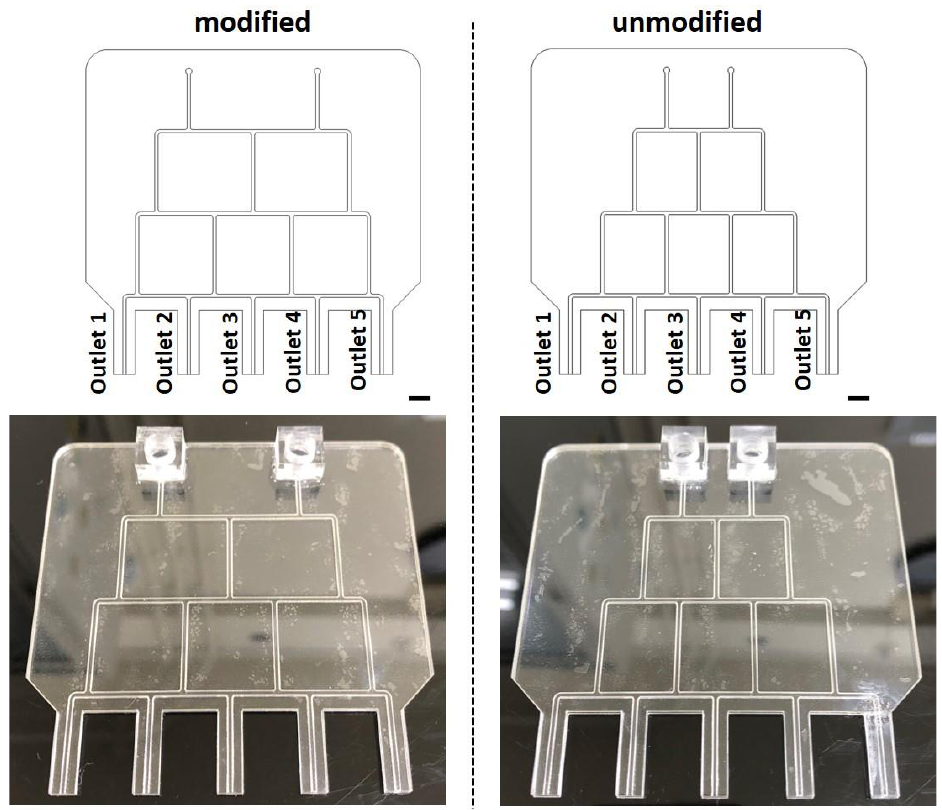
Figure 3. Unmodified ( right ) and modified ( left ) microfluidic chips with R V = R H . Scale bar = 5